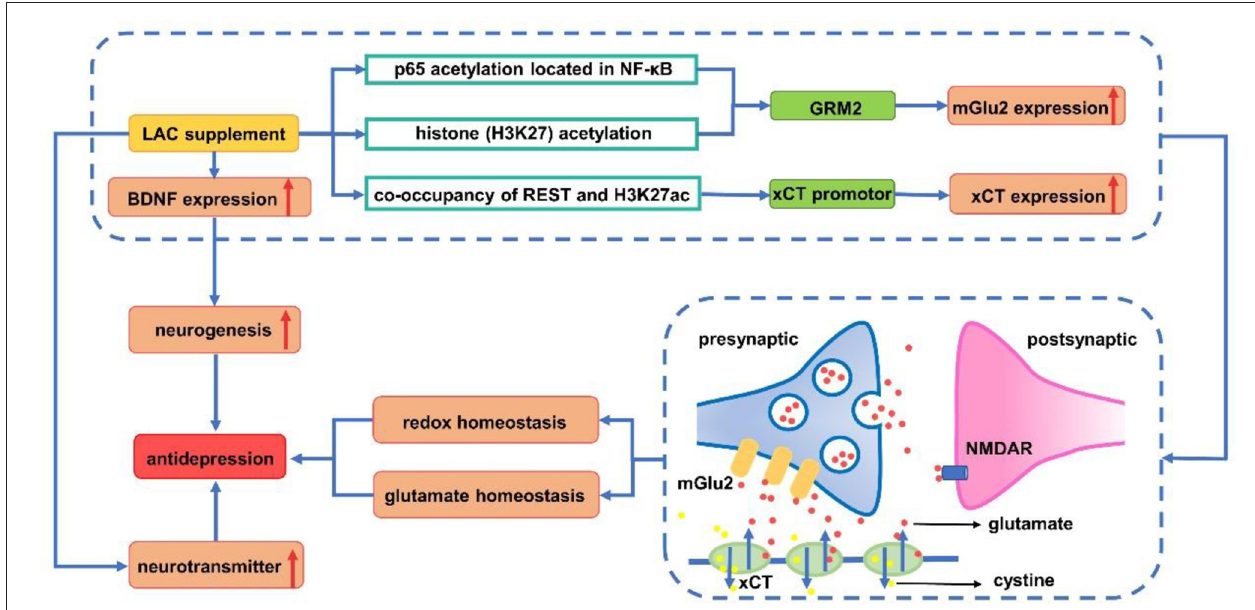
FIGURE 3 | Antidepressant mechanism of acetyl-L-carnitine. LAC supplement increases the expression of mGlu2 ( via up-regulating transcription of GRM2) by acetylating p65 on NF- κ B and H3K27. REST (repressor element 1 silencing transcription factor) and H3K27ac are enriched in the xCT promoter, promoting the expression of xCT. This in turn causes the release of glutamate out of the cell, which activates the mGlu2 receptor, and reduces the spillover of glutamate between synapses to enhance glutamate homeostasis. Meanwhile, xCT transports cystine into cells for the synthesis of glutathione to avoid oxidative stress damage. Upregulation of BDNF expression induced by LAC increases neurogenesis to exert antidepressant effects. Increase of monoamine neurotransmitters (such as 5-HT, DA, and NE) induced by LAC has demonstrated its antidepressant effect from the pathogenesis of depression. BDNF, brain derived neurotrophic factor; DA, dopamine; GRM2, glutamate receptor metabotropic 2; H3K27ac, acetylated H3K27; 5-HT, serotonin; LAC, acetyl-L-carnitine; mGlu2, metabotropic glutamate 2; NE, norepinephrine; NMDAR, N-methyl-D-aspartic acid receptor; REST, repressor element silencing transcription factor; xCT: Xc-cystine/glutamate